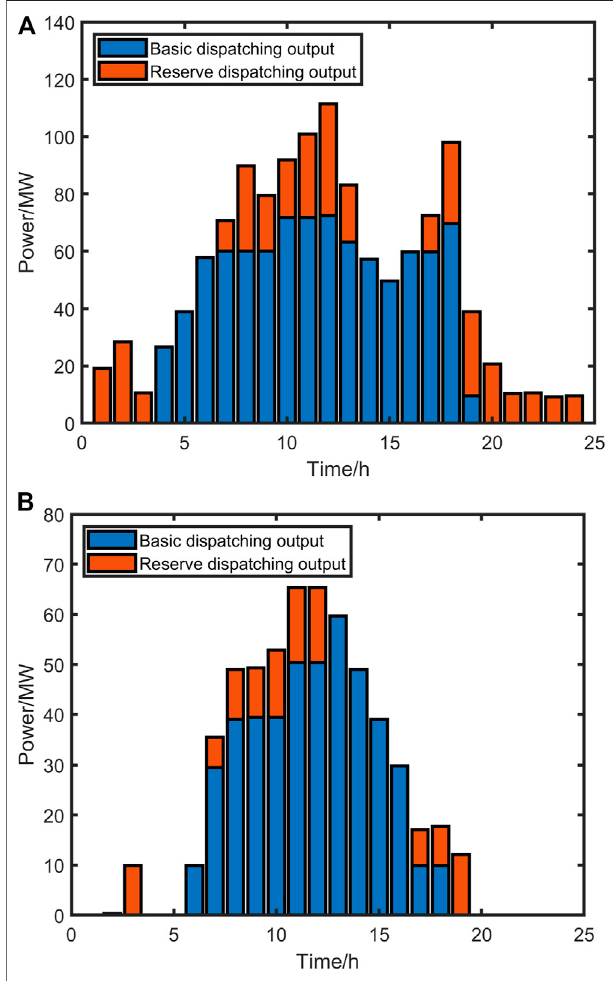
FIGURE 7 | The power of basic dispatching and reserve of G1. (A) Scenario 1. (B) Scenario